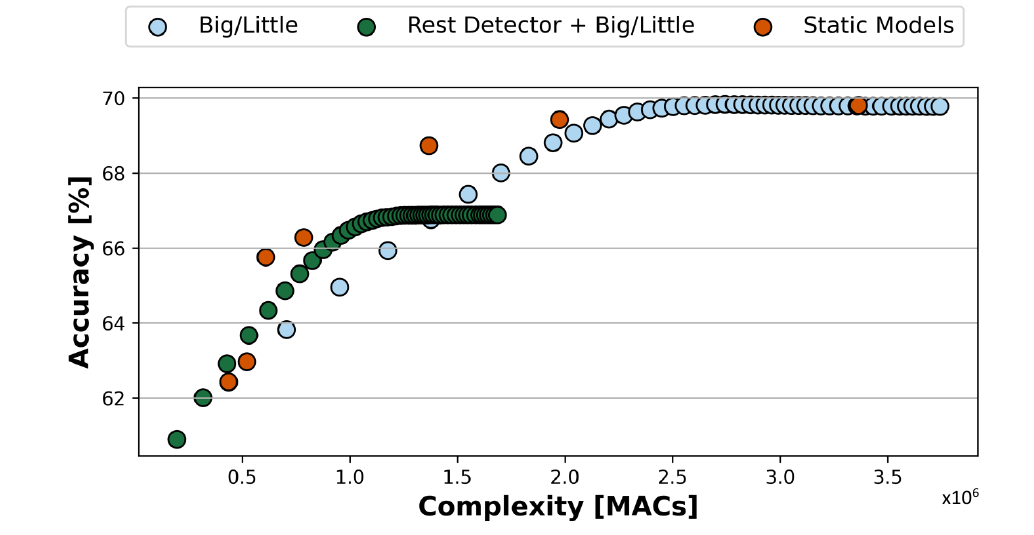
Figure 7. Dynamic inference